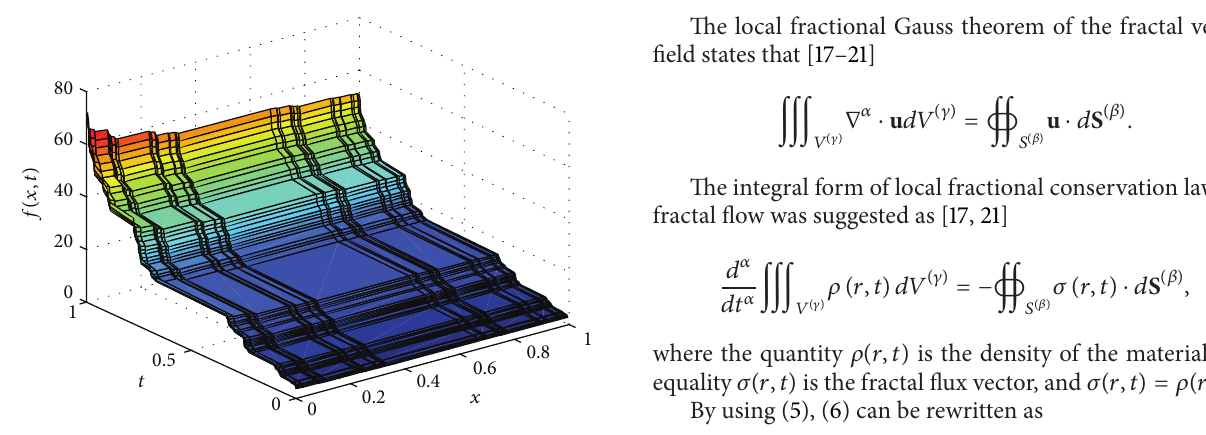
Figure 1: The nondifferentiable physical quantity 𝑓(𝑥,𝑡) defined in Cantor sets with time 𝑡 and space 𝑥